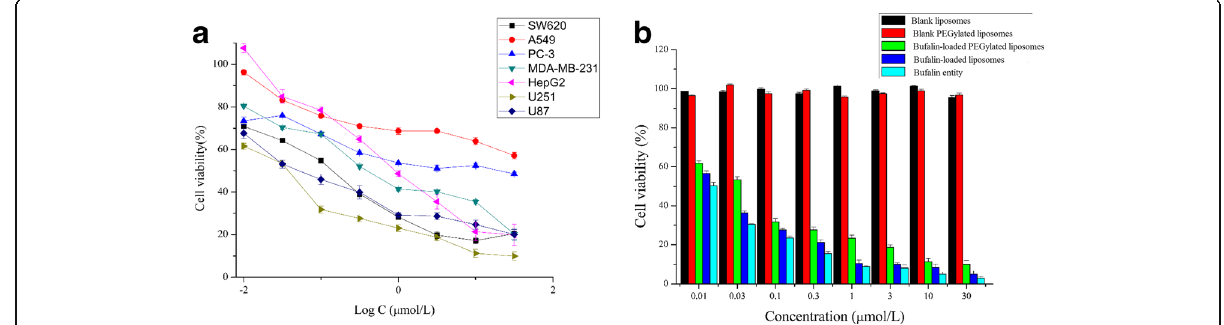
Fig. 3 In vitro cytotoxicity of blank liposomes, blank PEGylated liposomes, bufalin entity, bufalin-loaded liposomes, and bufalin-loaded PEGylated liposomes against tumor cells. a Cell viability of several kinds of tumor cell lines at various concentrations of bufalin entity. b Cell viability of U251 cells at various concentrations of blank liposomes, blank PEGylated liposomes, bufalin entity, bufalin-loaded liposomes, and bufalin-loaded PEGylated